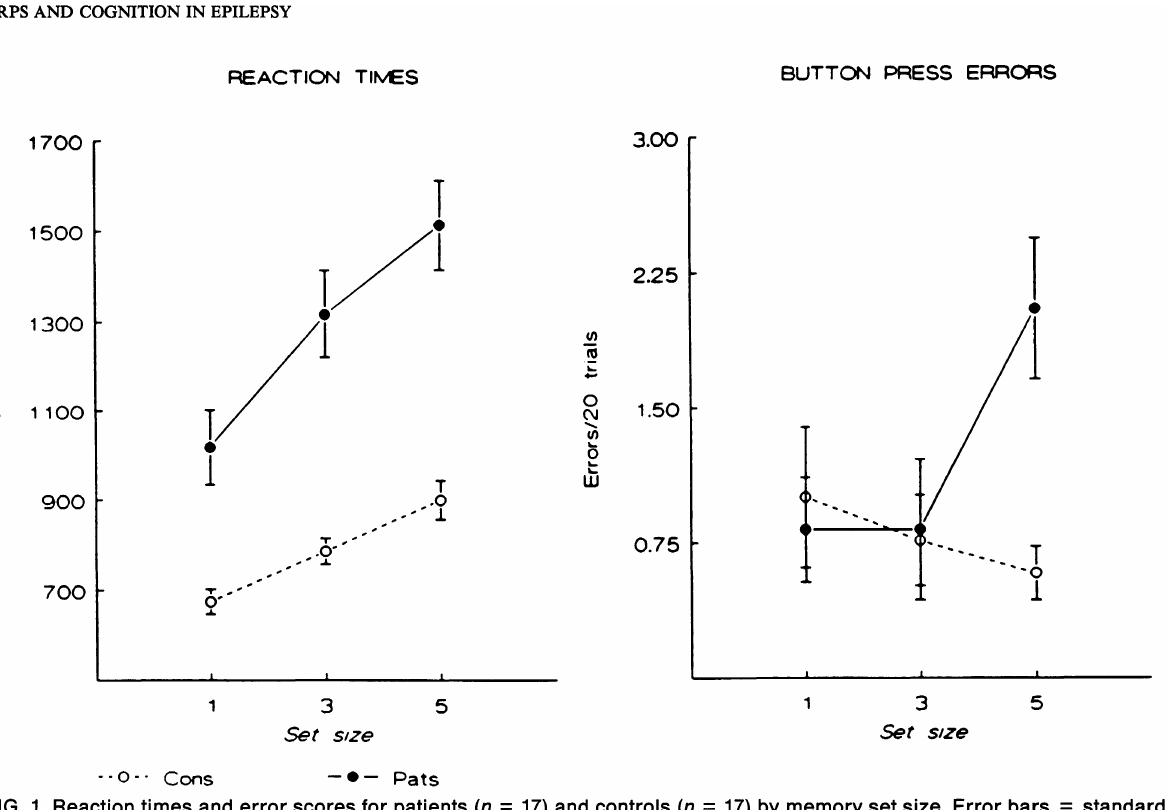
FIG. 1. Reaction times and error scores for patients (n error of the means. In left graph, note the steeper slope for the patients and their longer RTs at ali set sizes. For errors (right graph) note significant group differences occur only for five digit